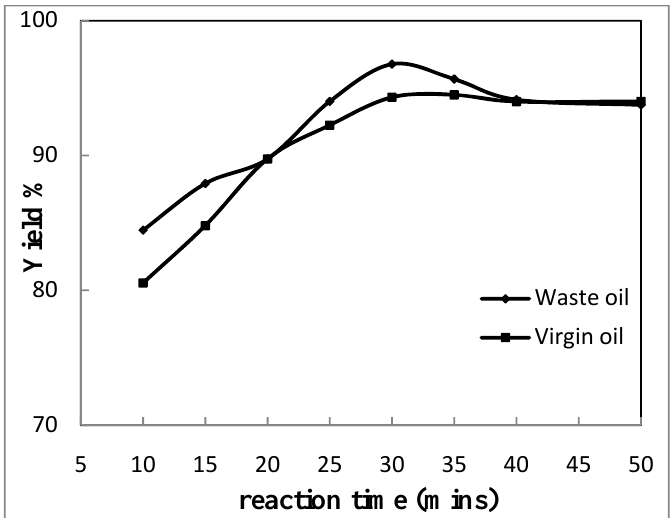
Figure 3. Effect of reaction time on FAME yield via the ultrasound under a